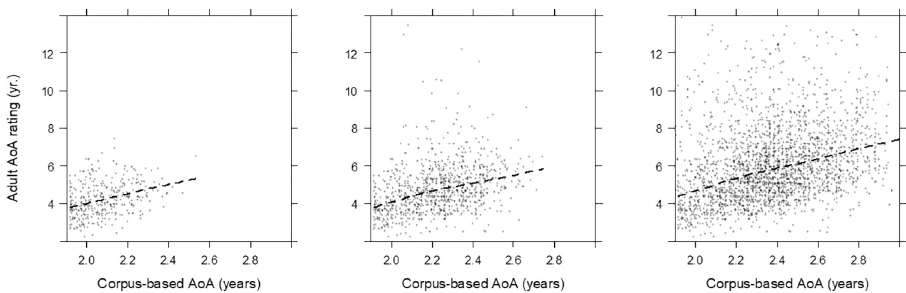
Fig 1. Relations between corpus-based AoA estimates and the adult AoA estimates. From left to right on x-axis is 12-child, 6-child, and 1-child word set.